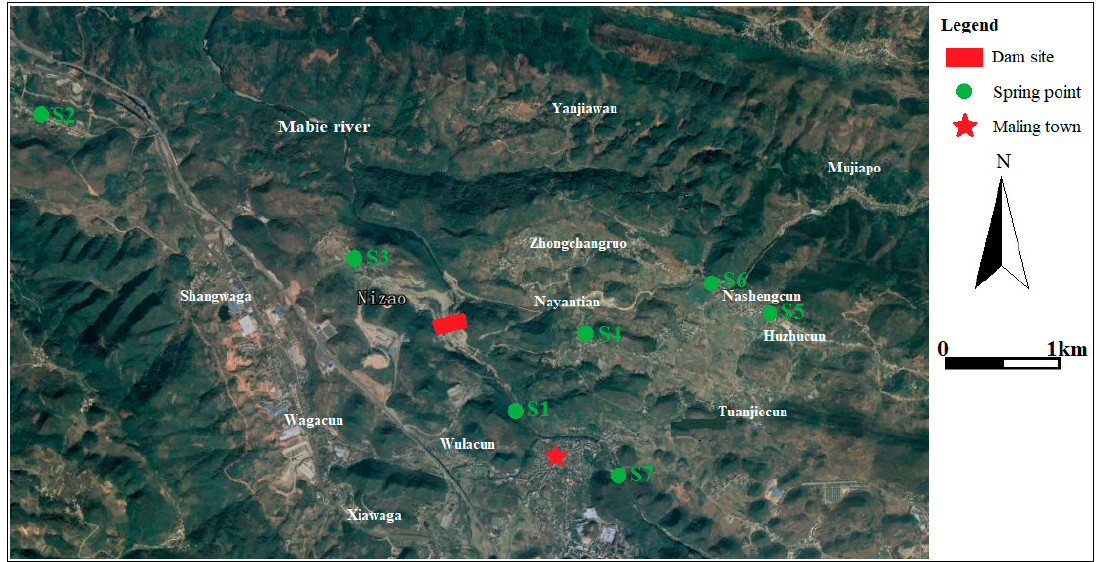
Figure 4. Distribution of karst spring water.